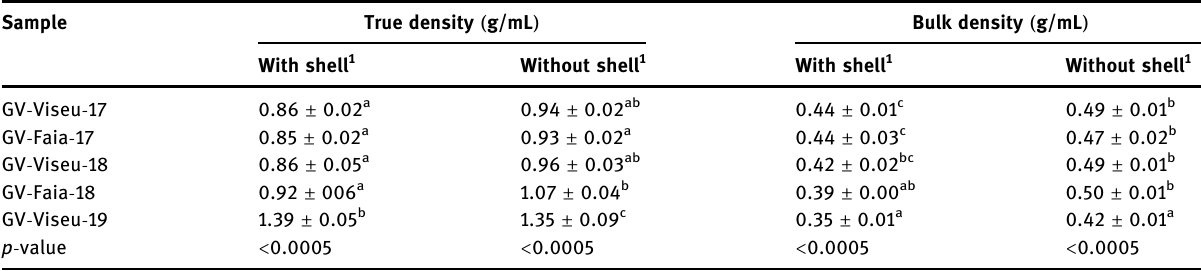
Table 4: Hazelnuts ’ density ( mean ± standard deviation )